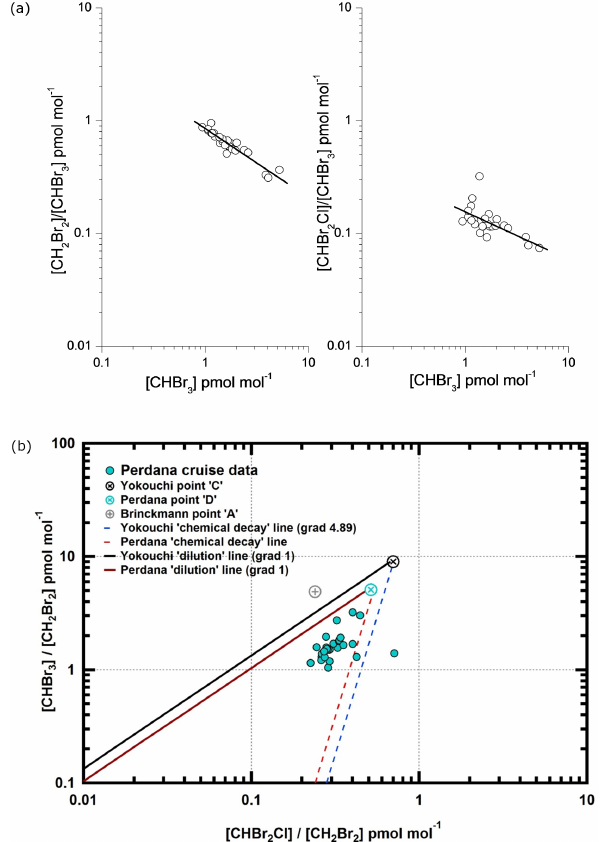
Figure 7. (a) Log–log plot CH 2 Br 2 /CHBr 3 and CHBr 2 Cl/CHBr 3 against CHBr 3 , and (b) log–log plots of CHBr 3 /CH 2 Br 2 against CHBr 2 Cl/CH 2 Br 2 for all stations during the Perdana cruise, fol- lowing Yokouchi et al. (2005) and Brinckmann et al. (2011). The solid line is the dilution line 1:1 and the solid dashed line is the chemical decay line estimated from the lifetime of the three species in the atmosphere. In this case, we have followed the example of Yokouchi et al. (2005) by using the lifetimes of 26 days (CHBr 3 ) , 69 days (CHBr 2 Cl) and 120 days (CH 2 Br 2 ) . The decay line thus has a slope of 4.89. The black point at the top of the data set is the point C in Yokouchi et al. (2005), and the grey point is the point A in the Brinckmann et al. (2011) log–log plots where CHBr 3 /CH 2 Br 2 is around 9 and CHBr 2 Cl/CH 2 Br 2 is around 0.7 from Yokouchi et al. (2005), and around 5 for CHBr 3 /CH 2 Br 2 and 0.2 for CHBr 2 Cl/CH 2 Br 2 from Brinckmann et al.